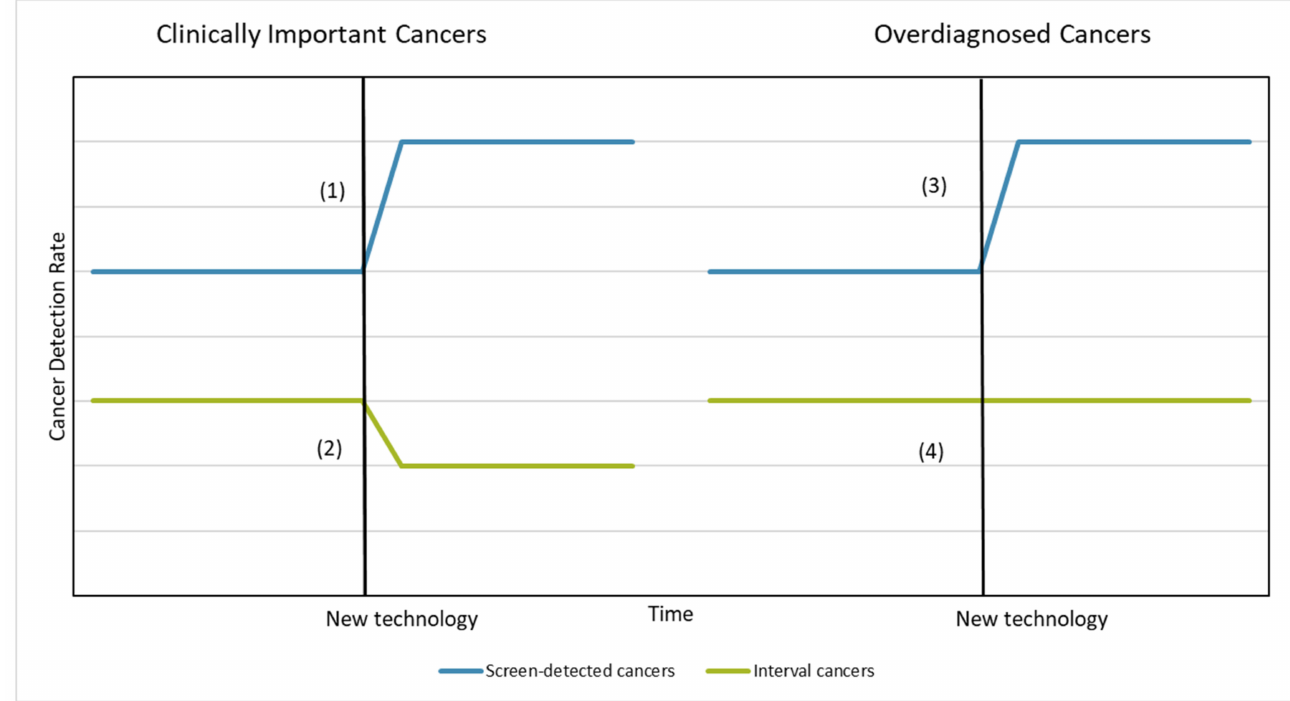
Figure 1. Potential scenarios following the introduction of a new technology to a screening